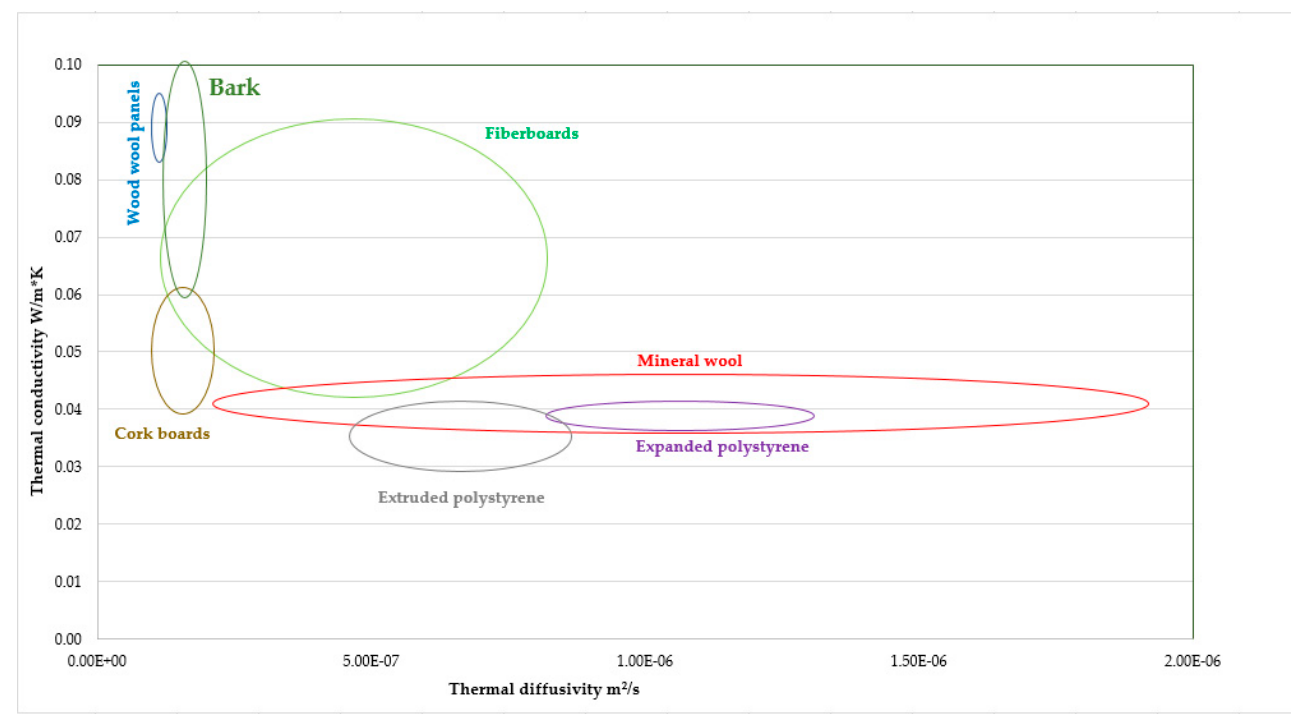
Figure 3. Thermal conductivity vs. thermal diffusivity of insulation materials.